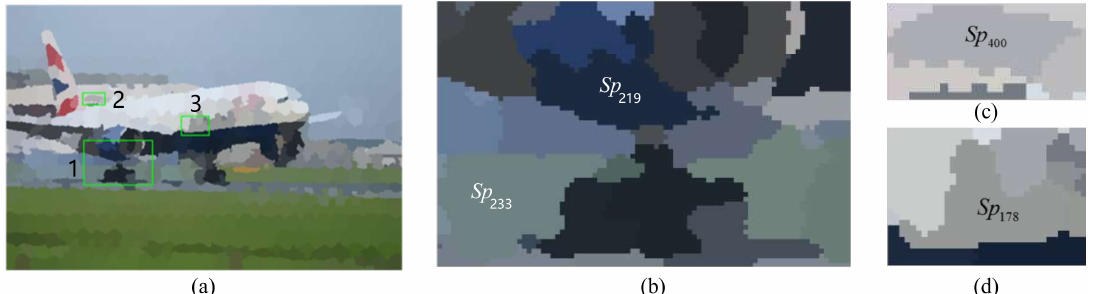
Figure 4. Example of superpixel semantic annotation. ( a ) The superpixel segmentation map; ( b ) region 1 in ( a ); ( c ) region 2 in ( a ); and, ( d ) region 3 in ( a